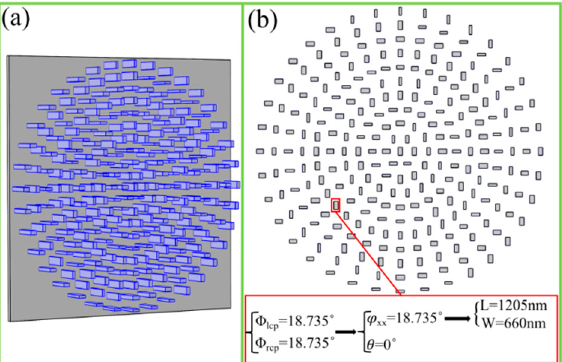
Figure 4. ( a ) Schematic of the spin-independent vortex metalens. ( b ) Top view of spin-independent vortex metalens, and the designing concept and specific parameters’ selection of a unit cell.